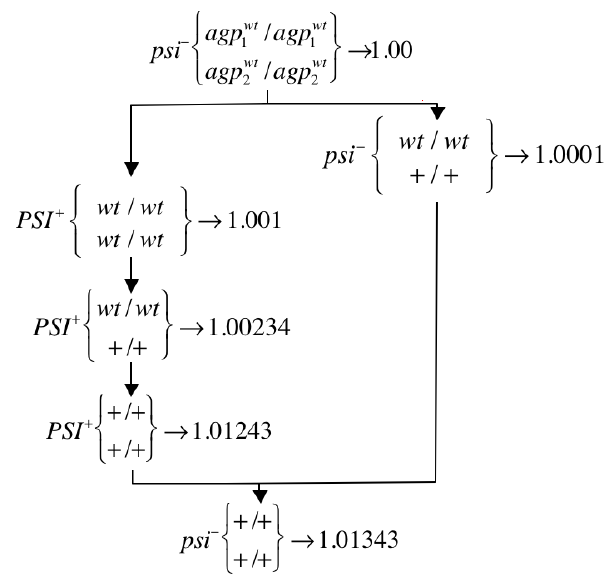
Figure 2. Alternative pathways, with and without [ PSI + ], leading to the same readthrough adaptation. Adaptation in environment 2 can proceed either via: (1) [ PSI + ] appearance followed by point mutation at agp loci (genetic assimilation) and finally reversion to [ psi 2 ] (left) and (2) direct adaptation at agp loci without involvement of [ PSI + ] (right). The fitness of an individual is given to the right of its genotype, calculated using s 2 =0.001. Only homozygous states are shown because inbreeding quickly leads to homozygosity. The genetic assimilation pathway typically occurs more often because [ PSI + ] individuals appear far more often than [ psi 2 ] individuals who carry the ‘‘ + ’’ allele at both agp